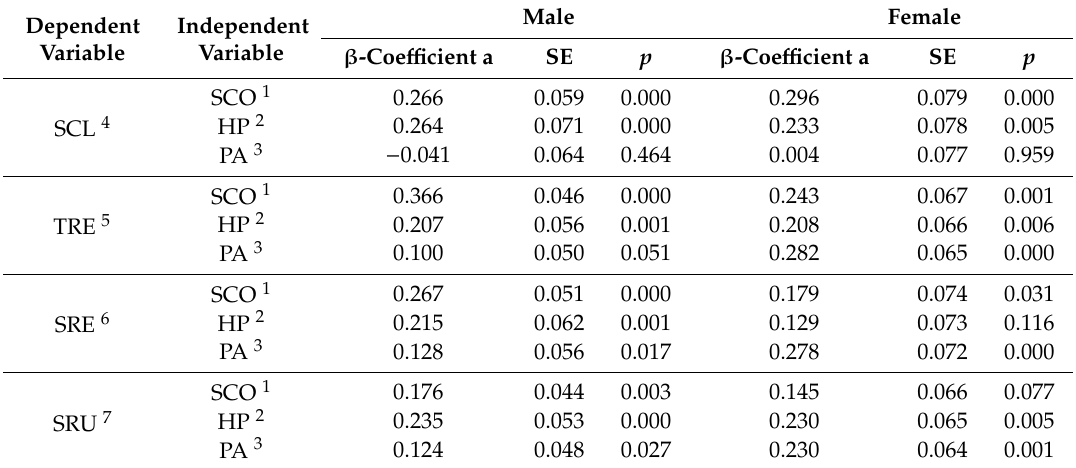
Table 6. Linear Regression of Physical Self-Concept and School Adjustment According to Sex (n = 589).